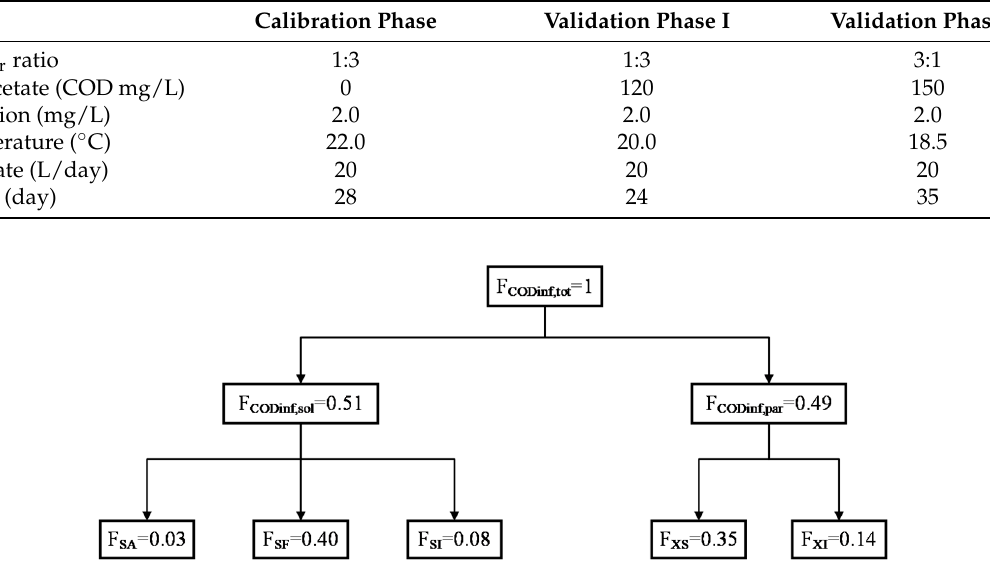
Table 1. DOPs of the lab-scale AAO system.